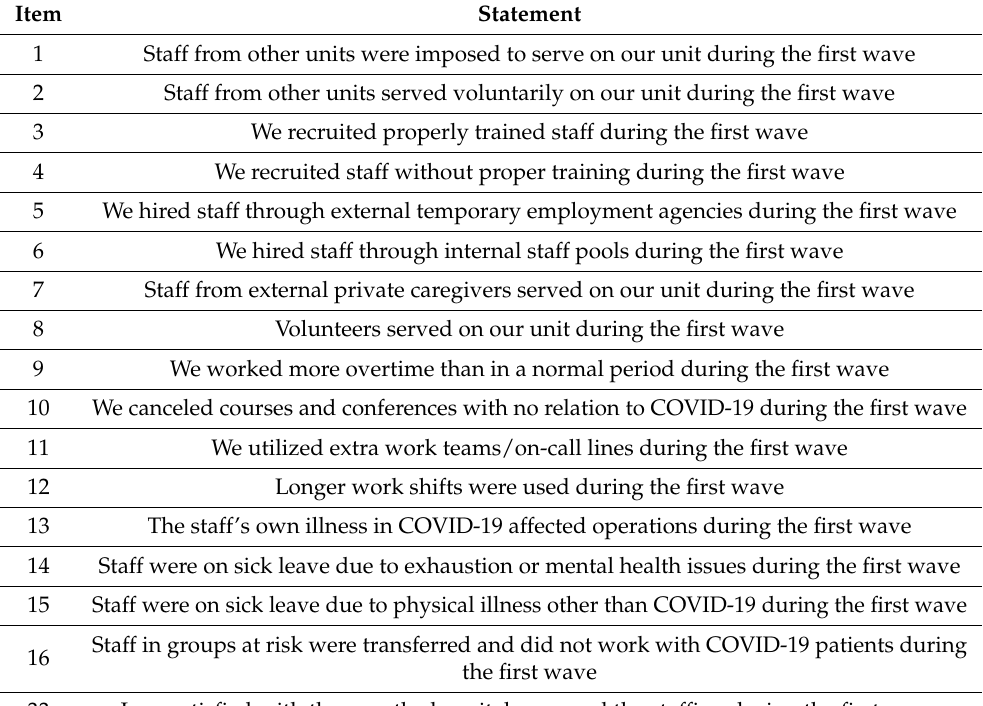
Table 1. The items developed for the